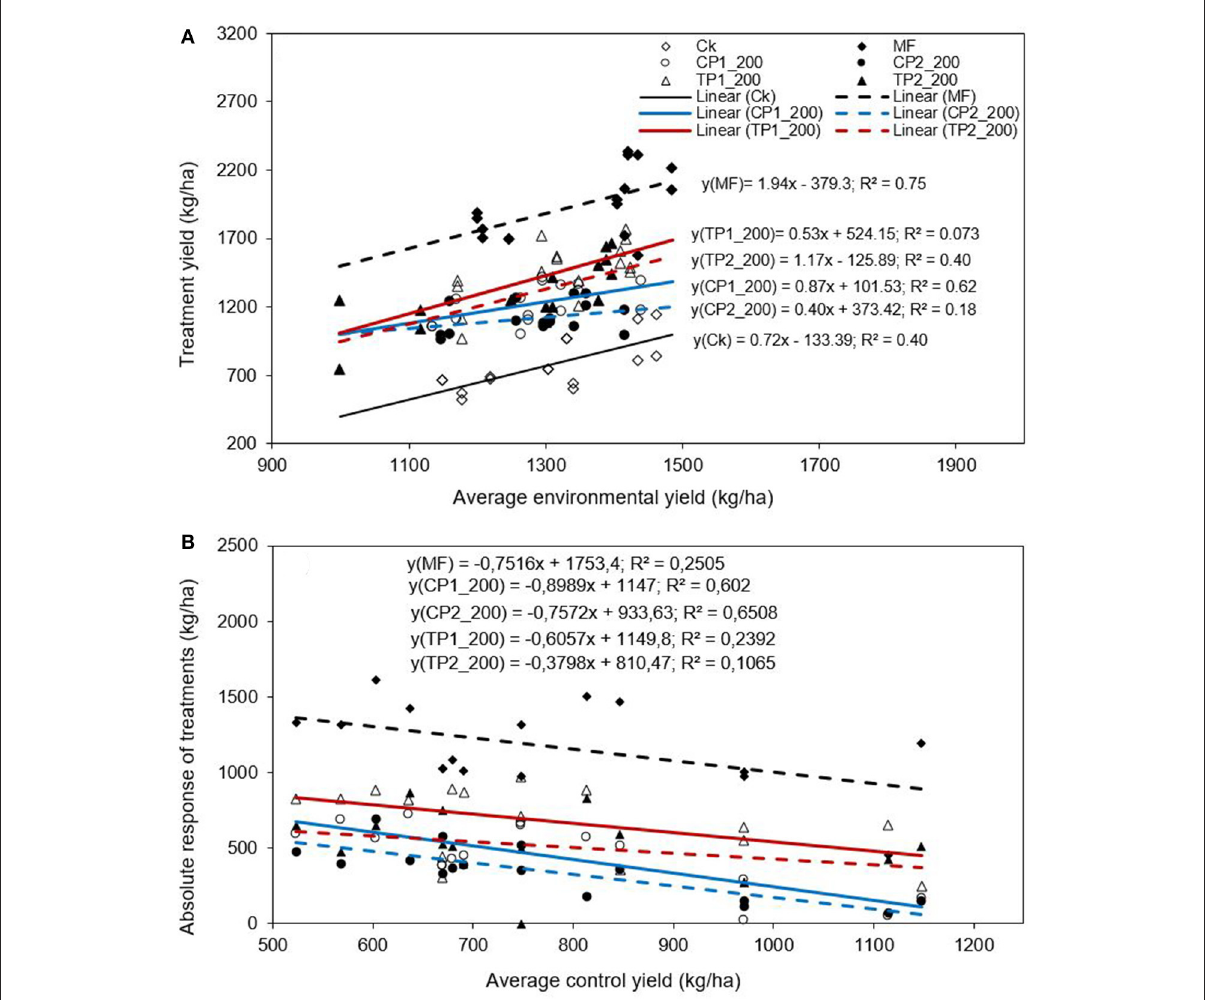
FIGURE4 Stability analysis (A) and absolute response of different treatments as a function of the yield of the control plot (B) . 4 The environmental average is the average yield of all treatments on a given agricultural site; Ck, control; MF, mineral fertilizer; CP1-200, Compost of Banikoara at 200 kg/ha; CP2-200, Compost of Toffo at 200 kg/ha; CP2-300, Compost of Toffo at 300 kg/ha; TP1_200, Terra preta of Banikoara at 200 kg/ha; TP2_200, Terra preta of Toffo at 200